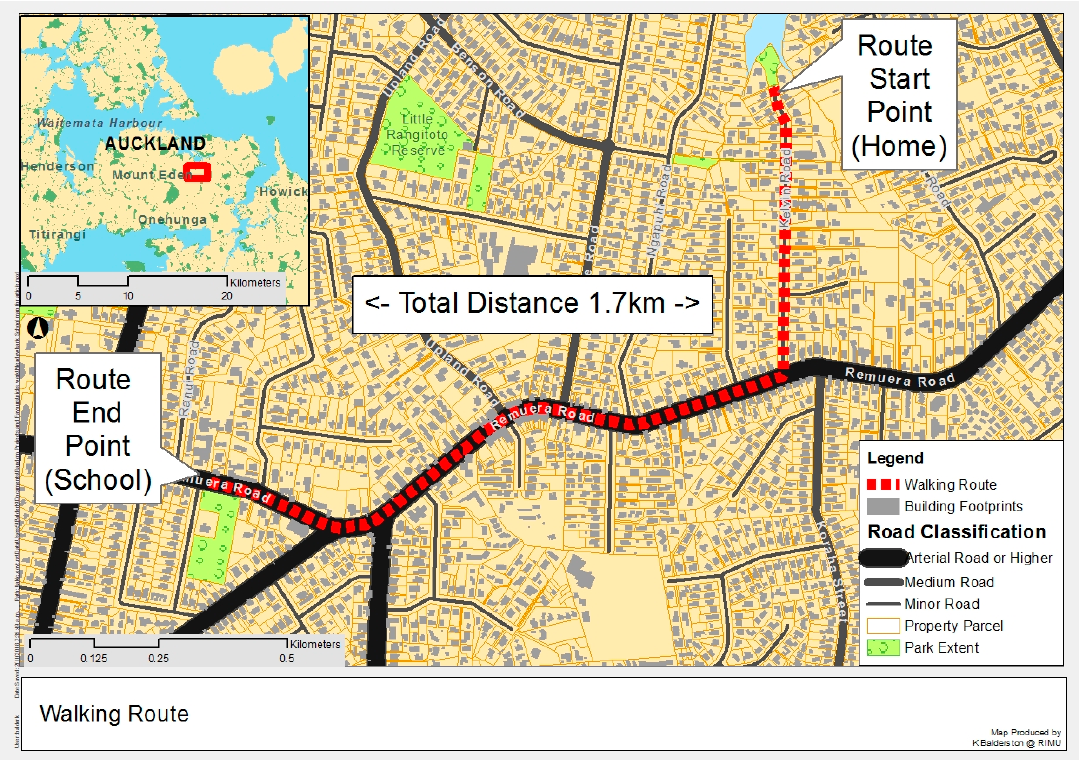
Figure 1. Walking route. Note the location of the start of the walking route (home) as well as the end (school) for the morning commute and the reverse for the journey home.